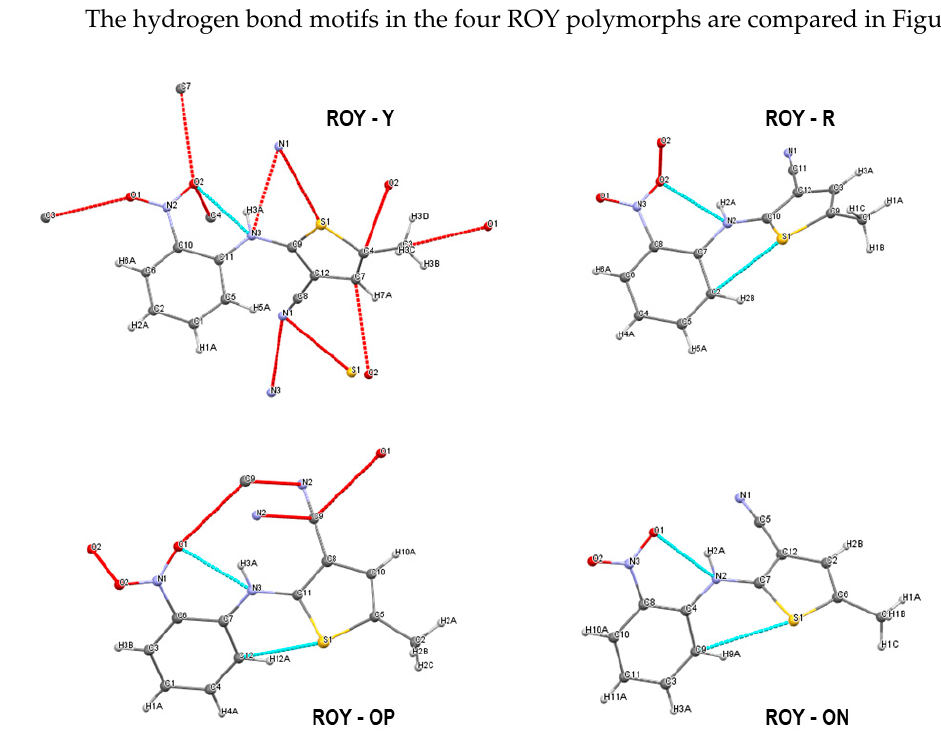
Figure 3. Hydrogen bonding motifs in different ROY polymorphs at 123 K. Polymorph Y has the largest number of intermolecular hydrogen bonds (red dotted lines), while polymorph ON has none. Intramolecular hydrogen bonds are shown as teal